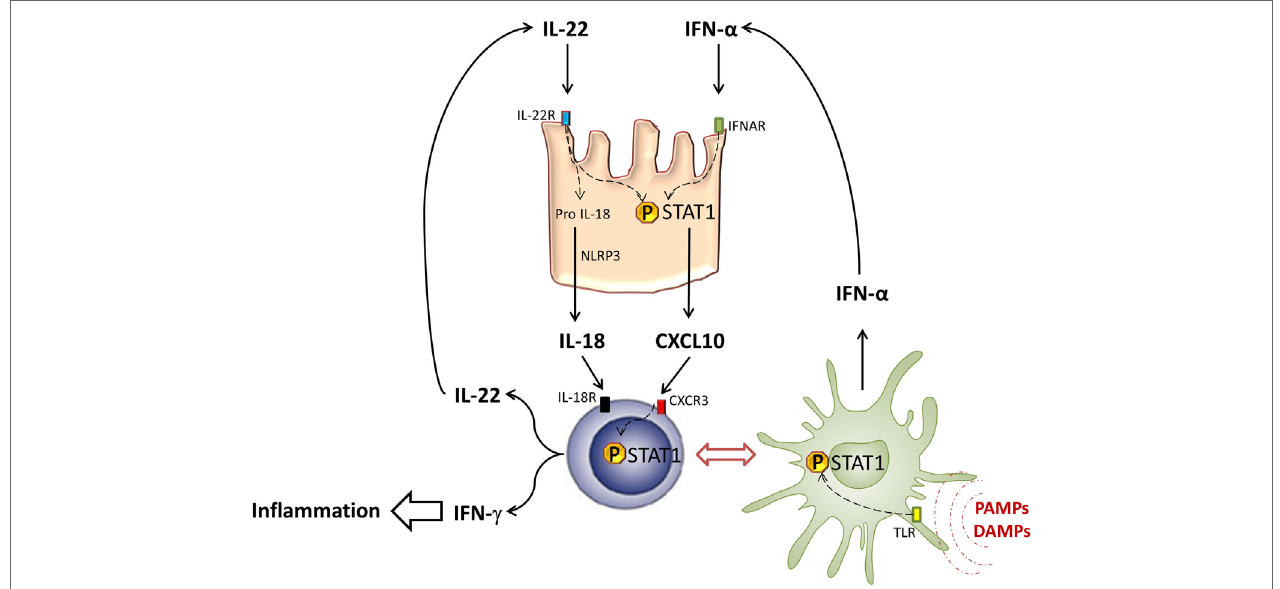
FiGURe 2 | STAT1 in intestinal inflammation . In response to PAMPs and DAMPs, pDCs (green cells) infiltrate intestinal tissues and secrete type-I IFN after TLR activation and STAT1 phosphorylation. Type-I IFN induces STAT1 activation in intestinal epithelial cells (pink cells), leading to local CXCL10 expression. CXCL10 induces CXCR3 + T cell (blue cells) recruitment and their differentiation into Th1, able to produce type-II IFN under STAT1 dependence. Thus, Th1 cells participate in local inflammation and also secrete IL-22 that contributes to STAT1 activation in